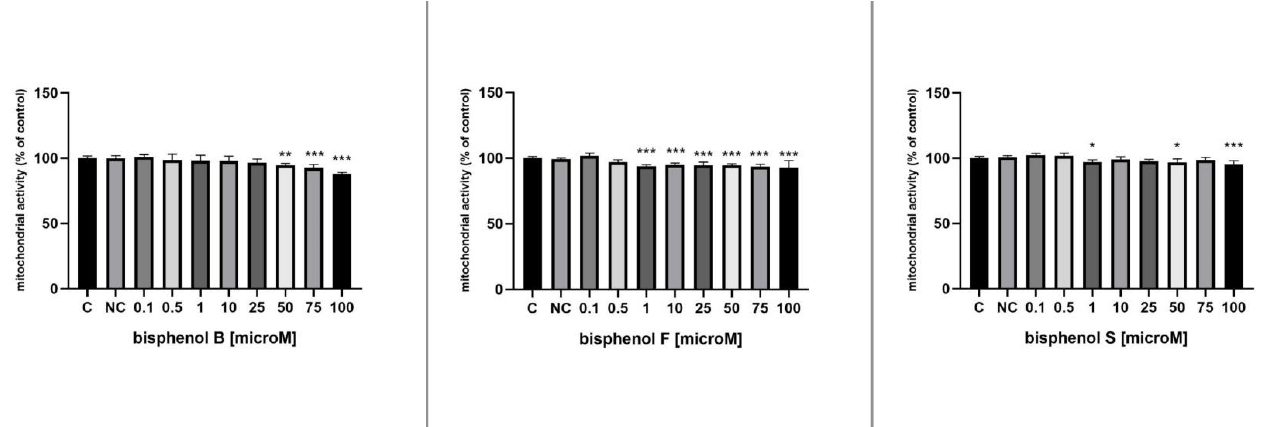
Figure 1. The impact of bisphenol B, F, and S on H295R cells’ mitochondrial activity in vitro. Abbreviations: C—control group, NC—negative control. The mean ( ± SEM) optical density percent of the control (untreated) and treated (bisphenol) groups is represented by each bar. The data were collected from three separate experiments. Between the control and experimental groups, the significance levels were established at *** ( p < 0.001), ** ( p < 0.01), and * ( p < 0.05).